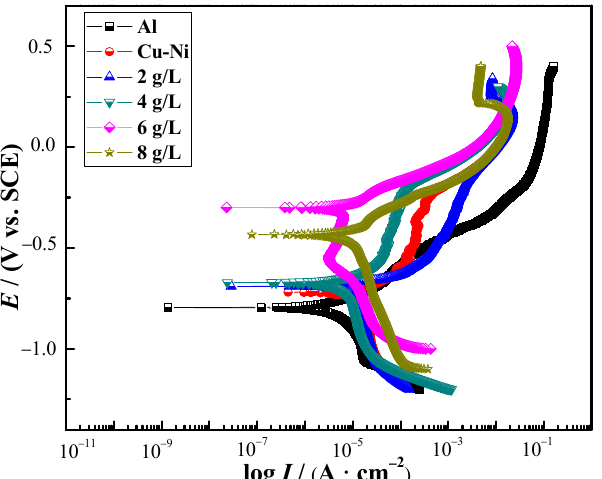
Figure 7. Polarization curves of Cu-Ni-ZnO nanocomposites with different (Cu, Ni)-ZnO additions. Table 2. Tafel fitting results of polarization curves of Cu-Ni-ZnO nanocomposite coatings with different (Cu, Ni)-ZnO